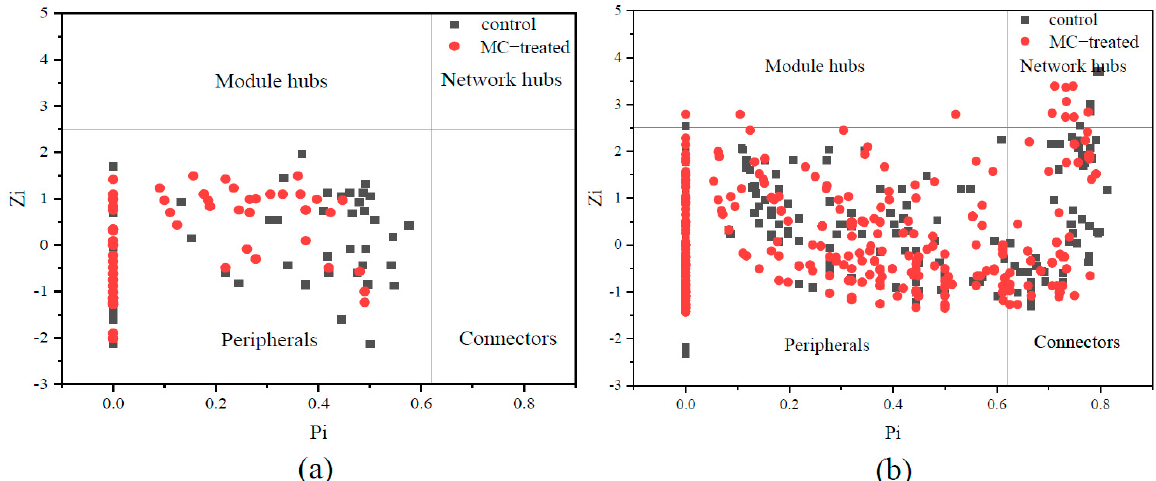
Figure 8. Zi–Pi plot showing the distribution of OTUs based on their topological roles: ( a ) phytoplankton and ( b ) bacteria. Each symbol represents an OTU under the control pond (black) or MC-treated pond (red). The topological role of each OTU was determined according to the scatter plot of within-module connectivity (Zi) and among-module connectivity (Pi). The nodes in a network are divided into the following four subcategories: peripherals (i.e., they have only a few links and almost always to the species within their modules), connectors (i.e., these nodes are highly linked to several modules), module hubs (i.e., they are highly connected to many species in their own modules), and network hubs (i.e., they act as both module hubs and connectors).